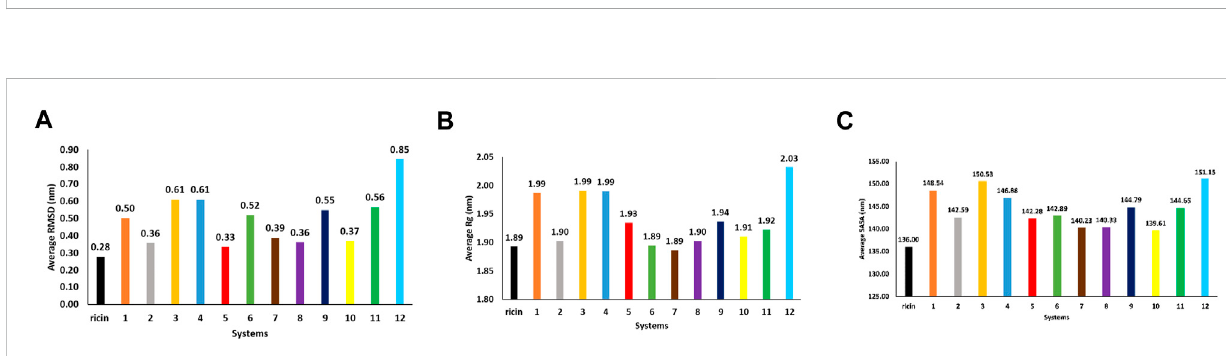
FIGURE 4 plots of average RMSD (A) , Rg (B) , and SASA (C) of all systems during 100-ns